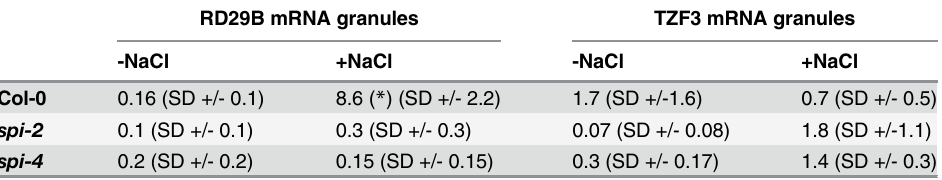
Table 4. Numbers of mRNA granules per cell (related to Fig 9). Average number of RD29B ( n = 65 cells) and TZF3 ( n = 120 cells) mRNA granules under non stress (-NaCl) and salt stress (+NaCl) conditions. SD val- ues represent standard deviations.